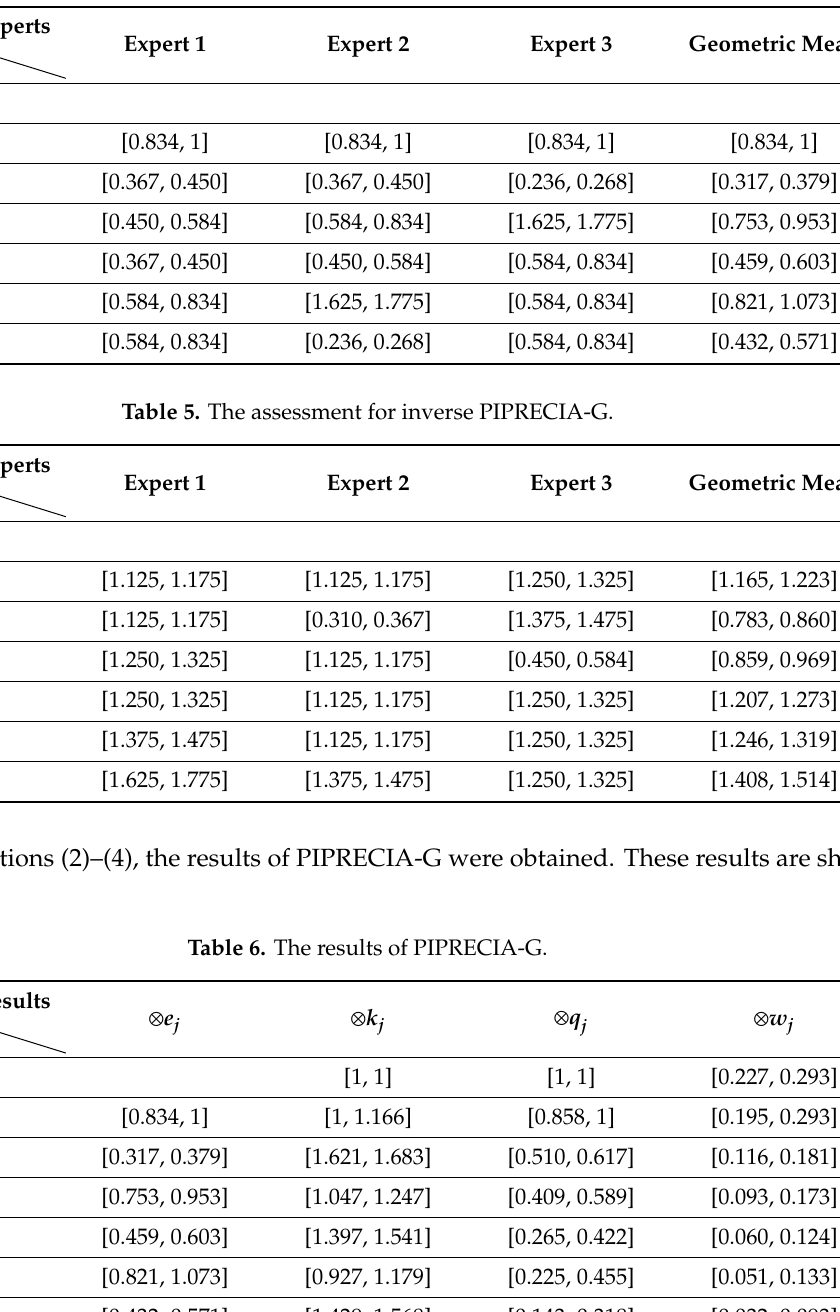
Table 4. The assessment for PIPRECIA-G.